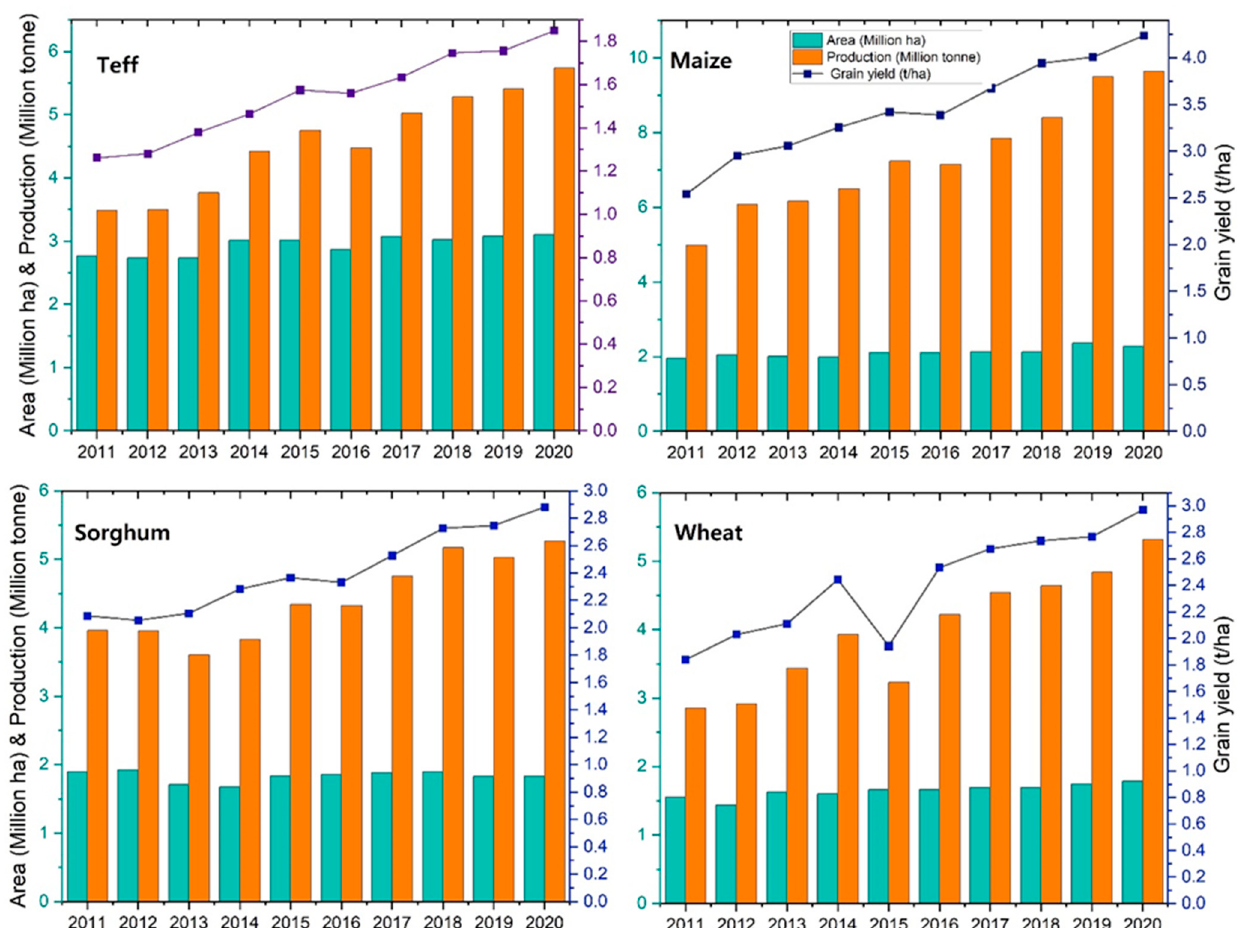
Figure 1. Changes in area, production, and yield of cereal crops between 2011 and 2020.